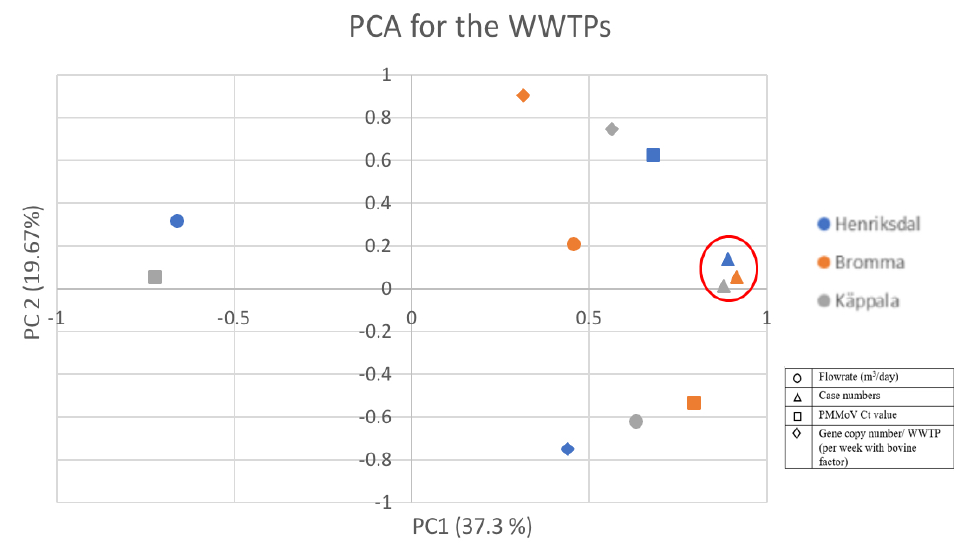
Figure 3. PCA plot illustrating similarity/dissimilarity between wastewater parameters and the SARS-CoV-2-positive cases of different regions in Stockholm.